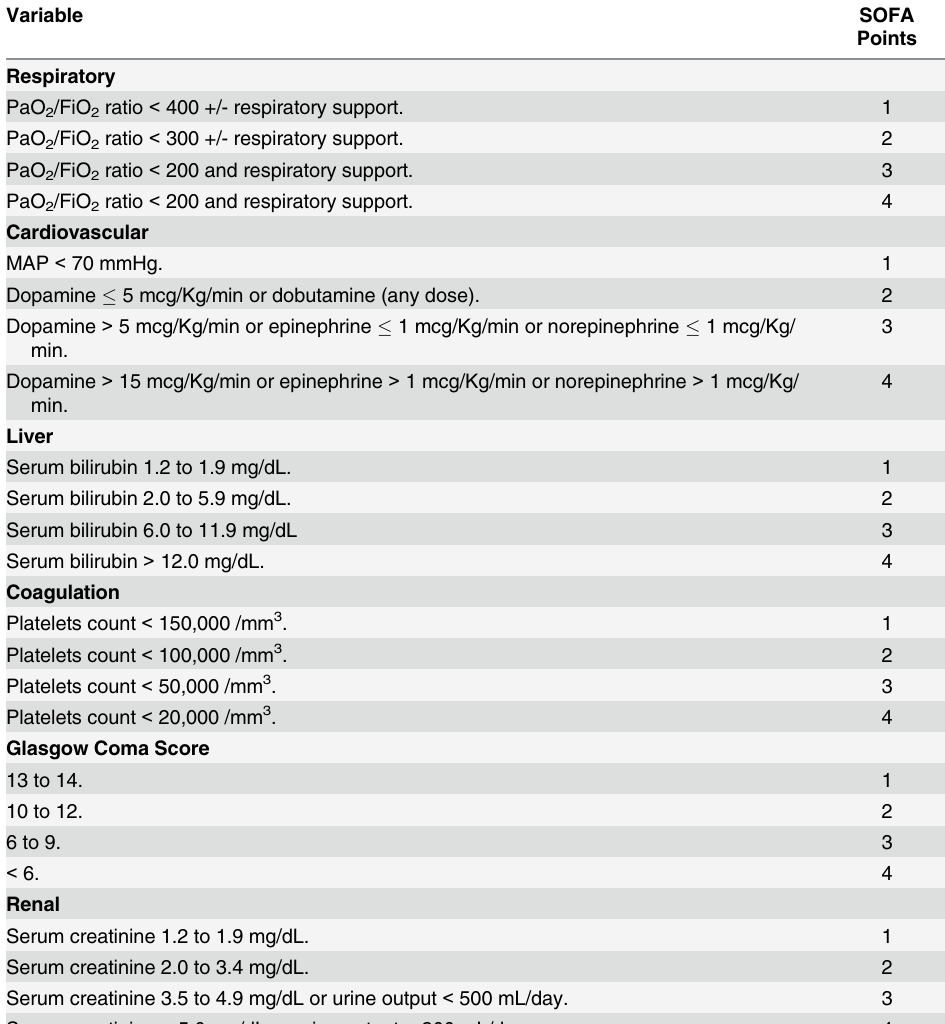
Table 2. SOFA (sequential organ failure assessment). Variable SOFA